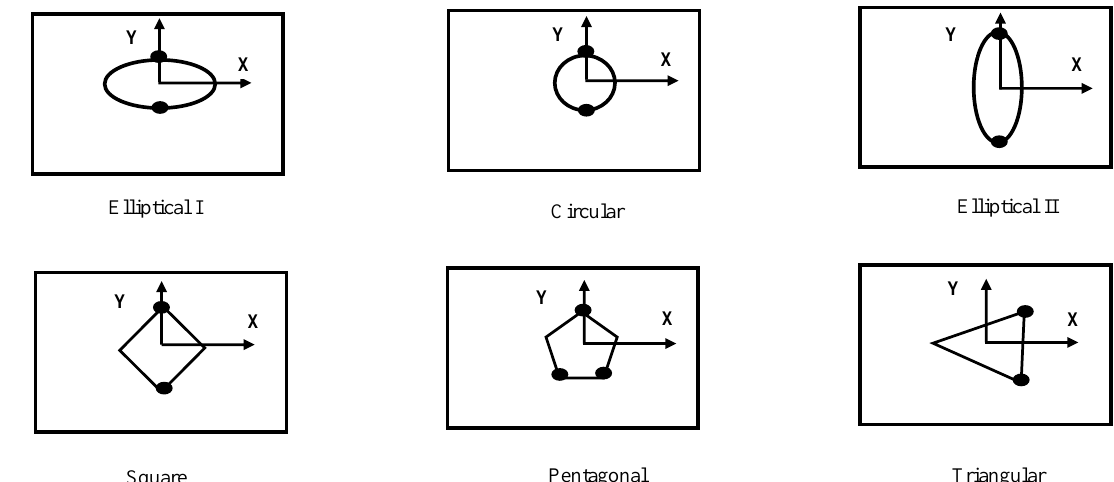
Figure 6: Different hole shapes considered for the study